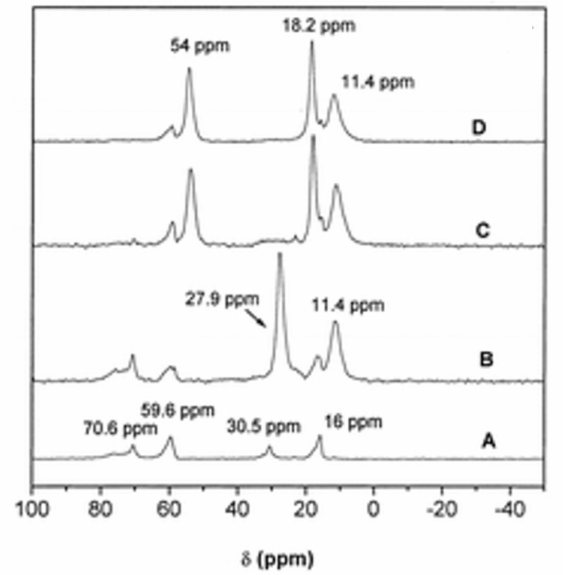
Figure 17. 13 CNMR spectra of different extracted SBA-15 mesoporous silicas: ( A ) conventional SBA; ( B ) thiol-functionalized SBA, ( C ) sulfonic-functionalized SBA-15 obtained through the direct- synthesis obtained through the direct-synthesis approach; ( D ) sulfonic-functionalized SBA-15 ob- tained through the direct-synthesis approach. Reprinted with permission from ref. [89]. Copyright 2000 American Chemical